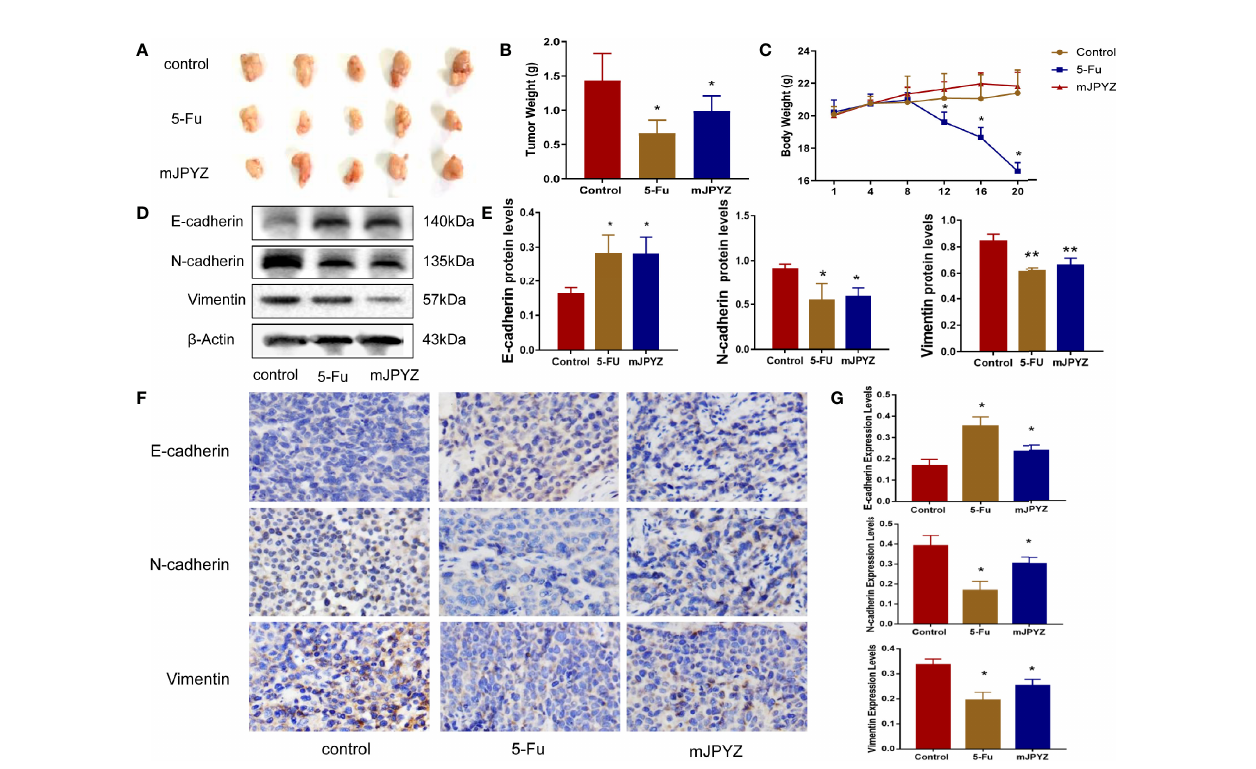
FIGURE 2 | mJPYZ decreased tumor growth and metastasis in vivo . (A) The gross manifestation and volumes of tumors. (B) The tumor weight. (C) The weight of the mice which recorded every 4 days. Effect of mJPYZ on the growth of SGC-7901 xenograft tumors (n = 5). (D, E) Western blotting analysis xenograft tumor tissues of essential proteins related to EMT. (F, G) Immunohistochemistry showed the rates of E-cadherin, N-cadherin and Vimentin expression. Compared to control, mJPYZ treatment increased the levels of E-cadherin, while decreased the levels of N-cadherin and Vimentin. Data are represented as mean ± SD, n=5 mice or n=3 independent experiments. *P < 0.05, **P < 0.01 versus control group by one-way analysis of variance (ANOVA) followed by Tukey ’ s post-hoc